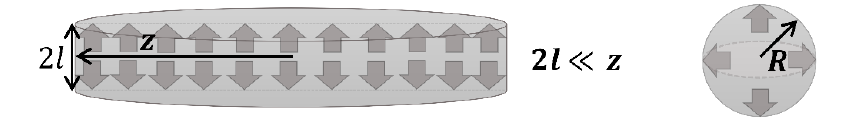
Figure 3. Methane emission from a plane sheet and a sphere.